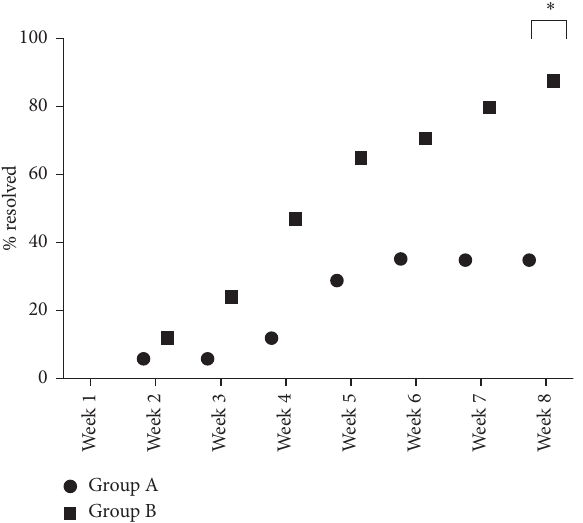
Figure 2: Percentage of dogs healed by treatment and study week. ∗ p < 0 . 01.